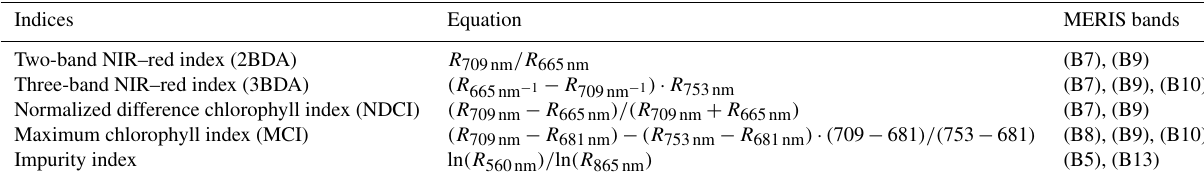
Table 1. Equations and MERIS bands used for calculation of different ratio indices. Indices